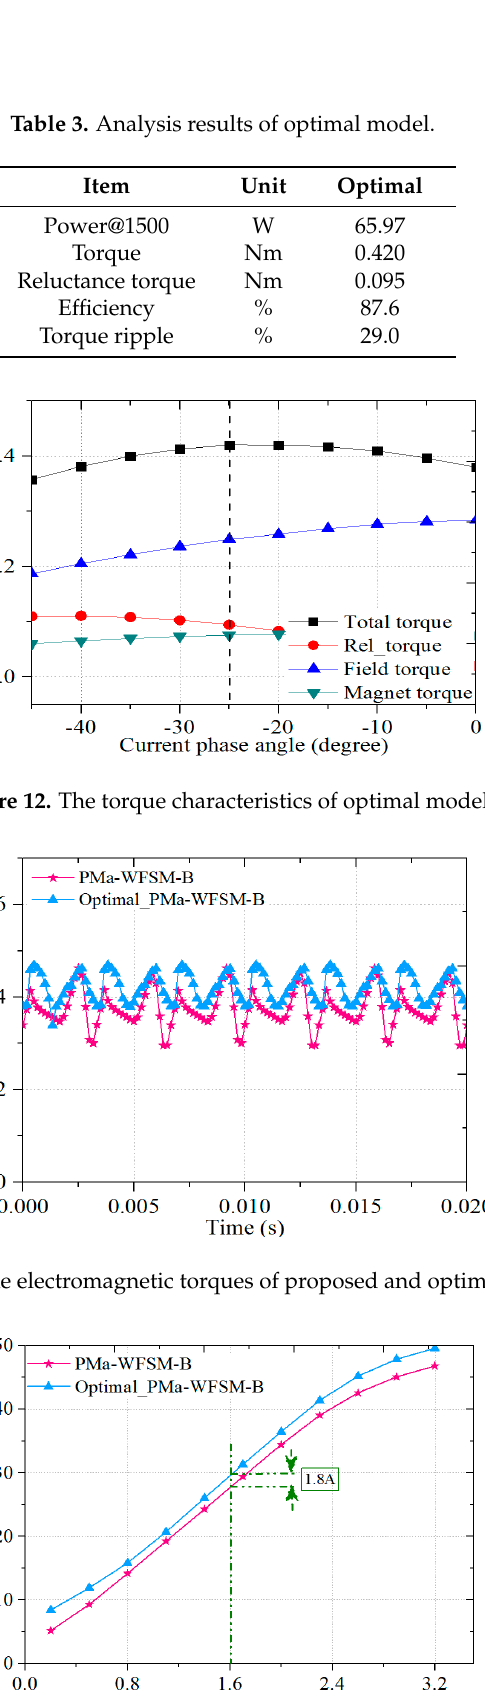
Figure 14. Calculated saturation curve of proposed model and optimal model.